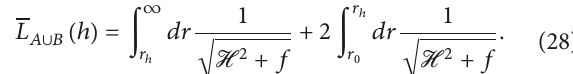
Figure 6: The Penrose diagram and geodesic length (horizontal colourful line) in the shock wave geometry. The left half of the surface is divided into three segments, labeled by black line, red line, and yellow line. The smallest value of 𝑟 attained by the surface is 𝑟 = 𝑟 0 , which marks the division between 2 and